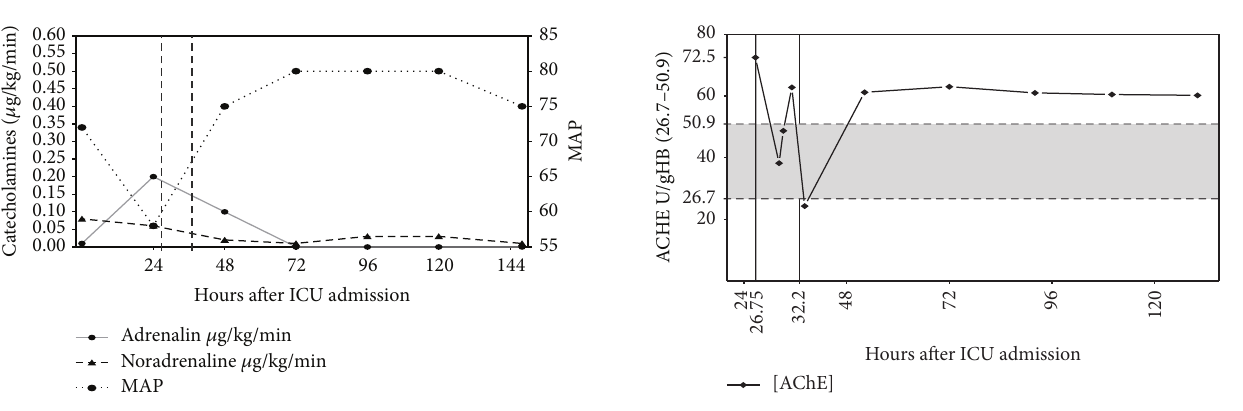
Figure 3: Levels of AChE activity. Moments of physostigmine application (hours after admission to the ICU) are highlighted with vertical lines. The shadow indicates the reference area of AchE